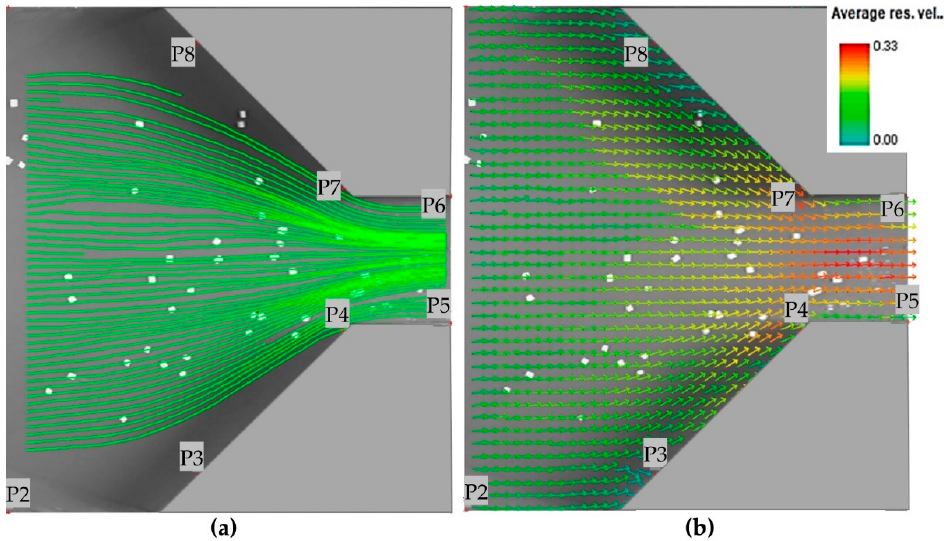
Figure 13. ( a ) Streamlines and ( b ) velocity vectors for Q = 0.064 m 3 /s and B 2 /B 1 = 0.25.